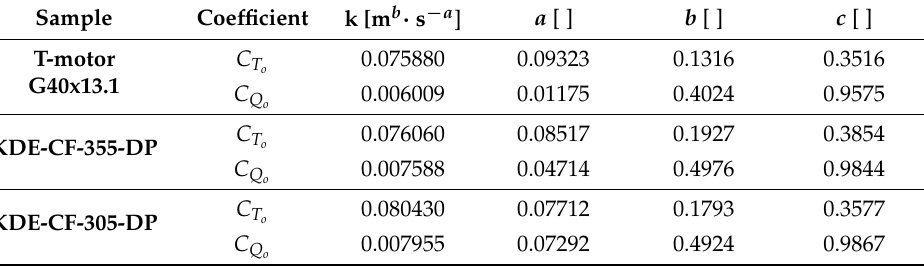
Table 5. Static thrust and torque coefficient model for sample propellers (Equation